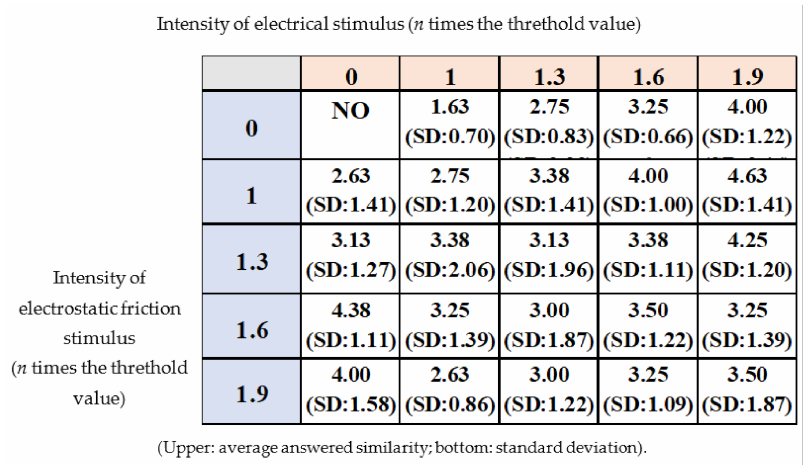
Figure 11. The similarity of the step as rated by the experimental